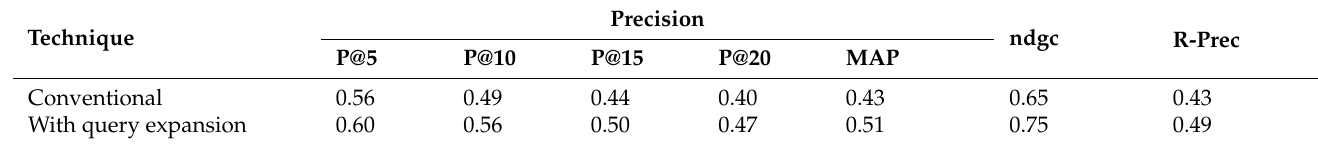
Table 12. Effectiveness of Amharic retrieval with and without query expansion.